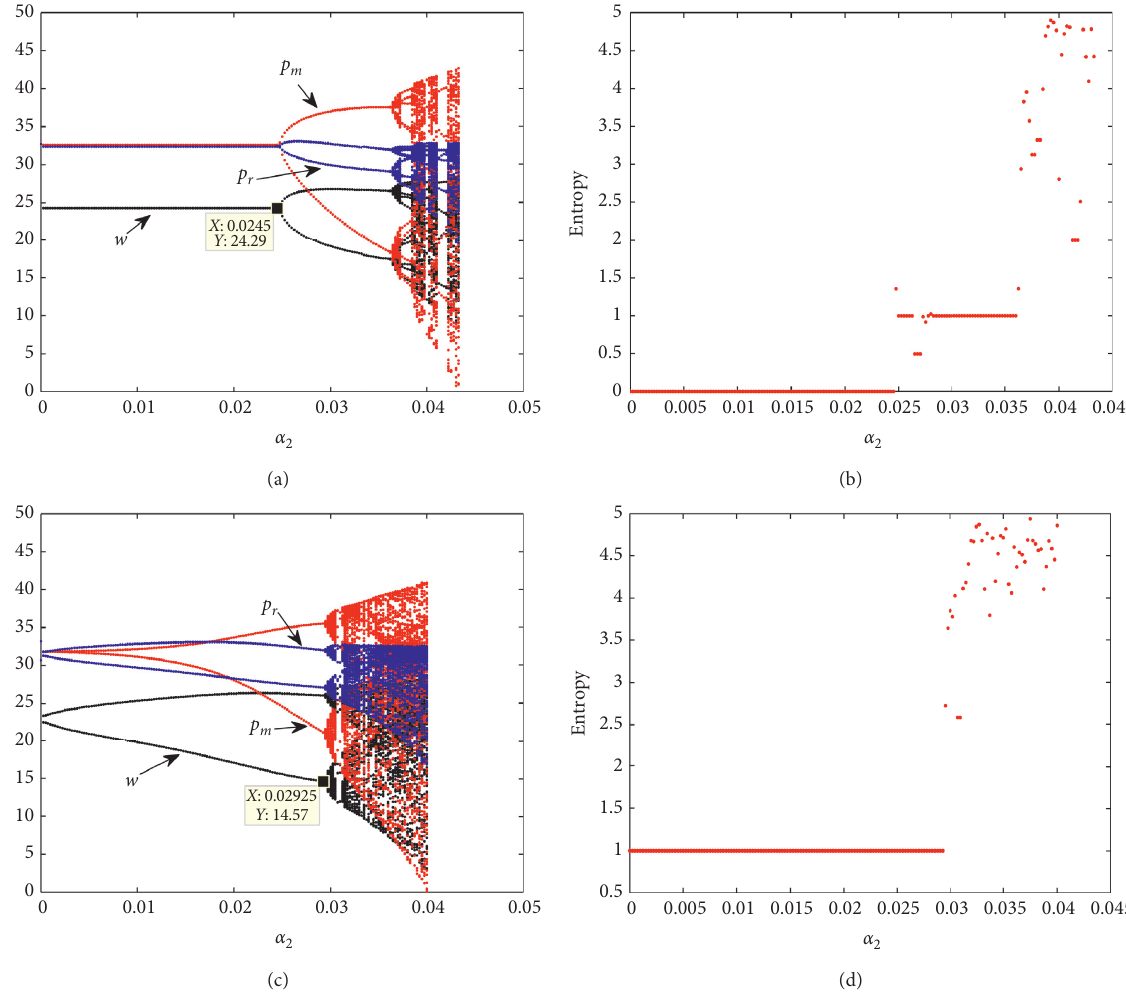
Figure 5: Bifurcation diagram and entropy of the dynamic system (17) with varying α � 0 . 6. (b) Entropy diagram when λ λ 2